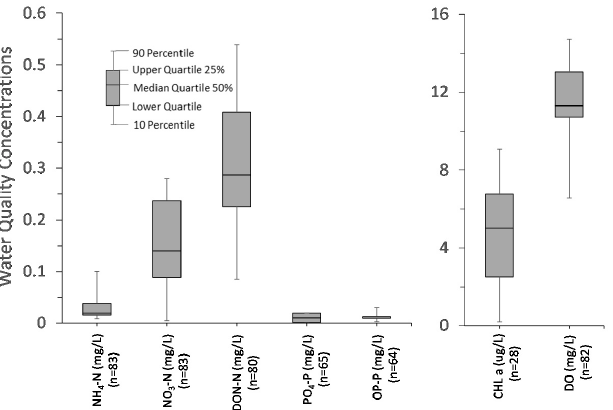
Figure 3. Range of concentrations occurring for water quality parameters at the upstream boundary condition used in the WASP7 model for the upper Qu’Appelle River. n indicates the number of observations.